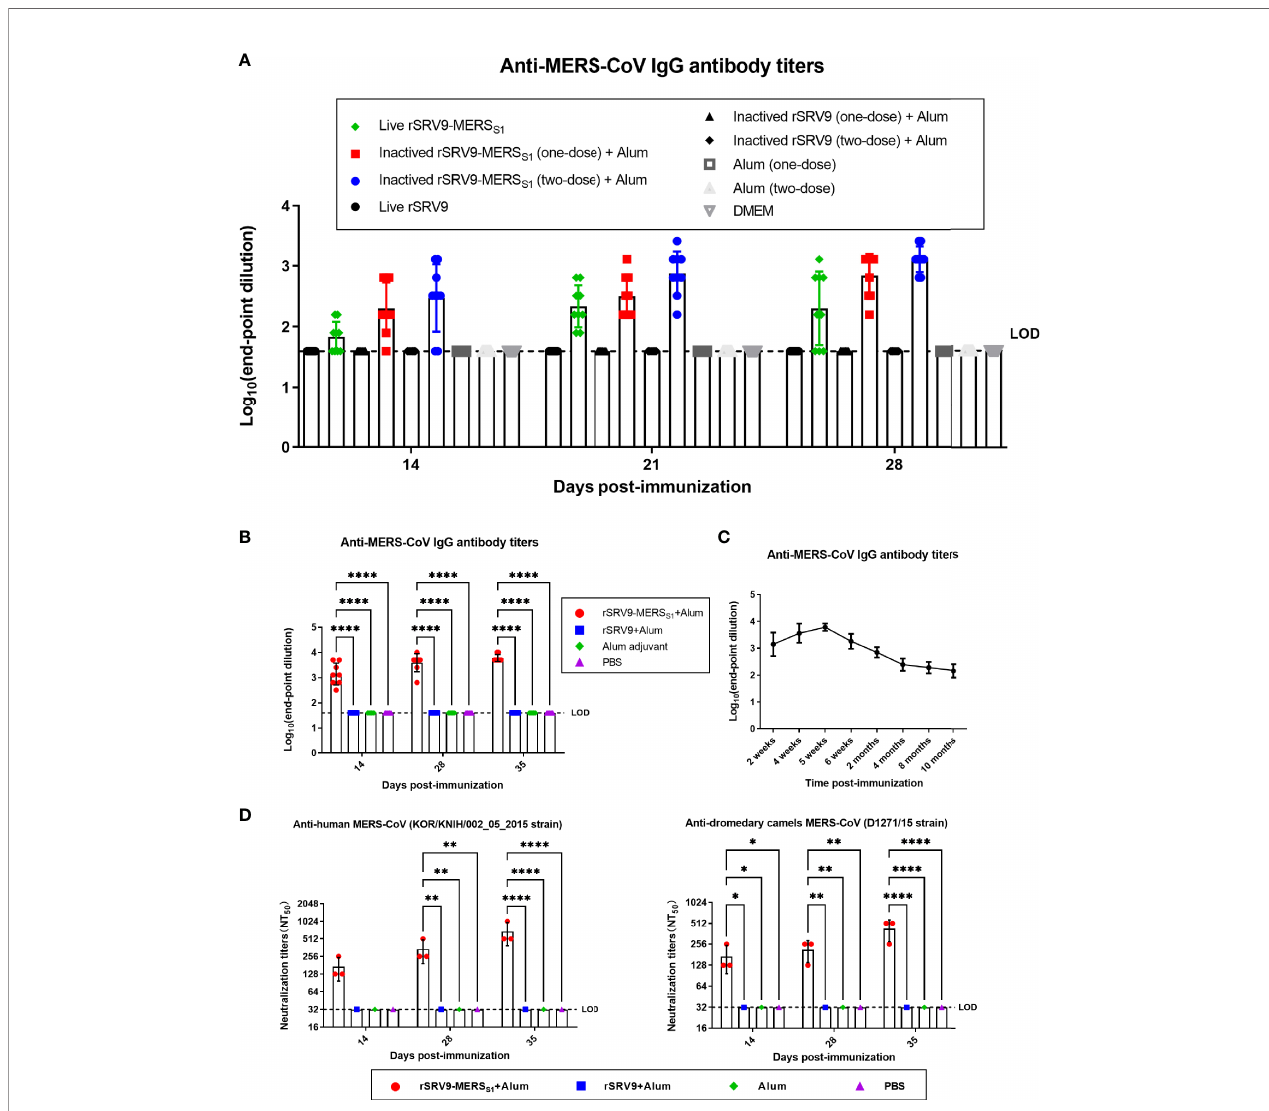
FIGURE 2 | Humoral immune responses against MERS-CoV elicited by the inactivated rabies virus-vectored MERS-CoV vaccine in mice. (A) Evaluation of an appropriate vaccine from recombinant rabies virus-vectored MERS-CoV vaccine candidates (n = 9 per group). The immunogenicity of the vaccine candidates with different forms (live and inactivated) and delivery doses (one dose assayed for both live and inactivated vaccines, two doses assayed for inactivated vaccine) was evaluated by anti-MERS-CoV IgG antibody through indirect ELISA. Endpoint dilution titers were calculated at the indicated time points. (B) The total anti-MERS-CoV IgG antibody titers of sera from each group of mice (n = 8) were assessed on days 14, 28, and 35 after the fi rst immunization and shown as endpoint dilution titers. (C) The dynamic changes and duration of serum antibodies from each group of mice (n = 8) were evaluated by indirect ELISA at the indicated time. (D) The cross- neutralizing activity against divergent MERS-CoV isolates (human MERS-CoV KOR/HIN strain and dromedary camel MERS-CoV D1271 strain) of sera from each group of mice (n = 3) were evaluated by a pseudovirus-based neutralization assay. Data are shown as mean ± SD. Data were obtained using GraphPad Prism version 9.0 (GraphPad software). Signi fi cance was calculated using a two-way ANOVA with multiple comparisons tests (not indicated in graph; *p < 0.05, **p < 0.01, ****p <